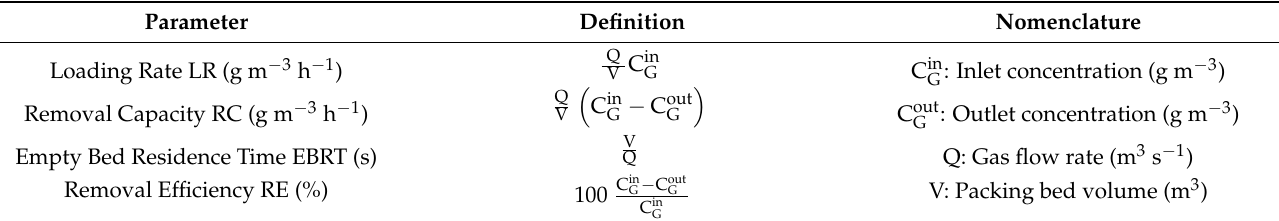
Table 3. Operating